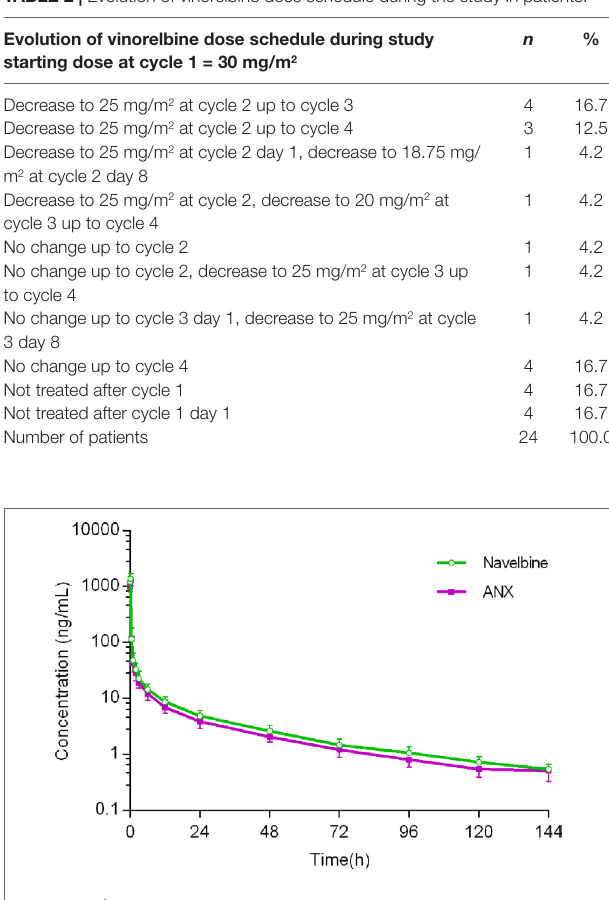
TABLE 2 | Evolution of vinorelbine dose schedule during the study in